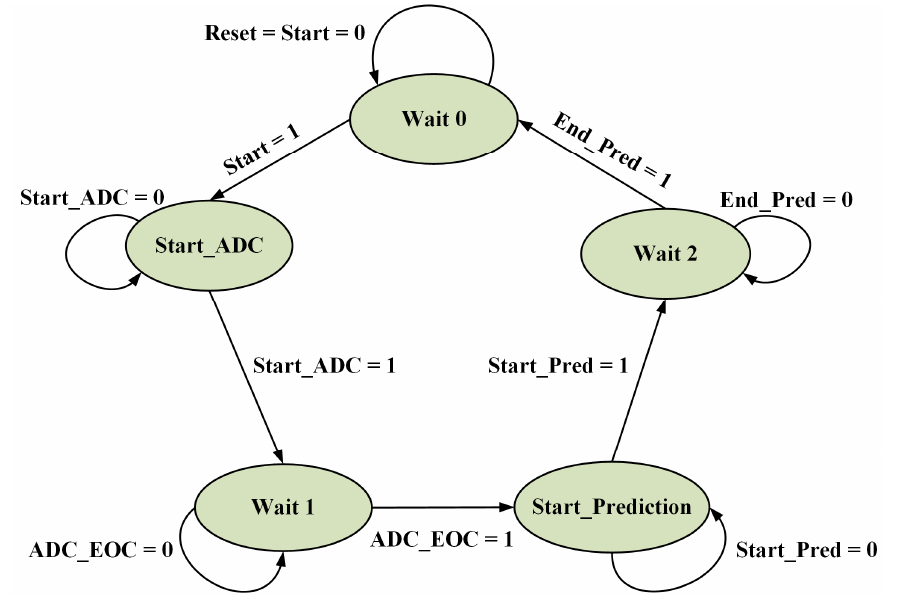
Figure 8. Finite state machine of the FS-PDCC control.